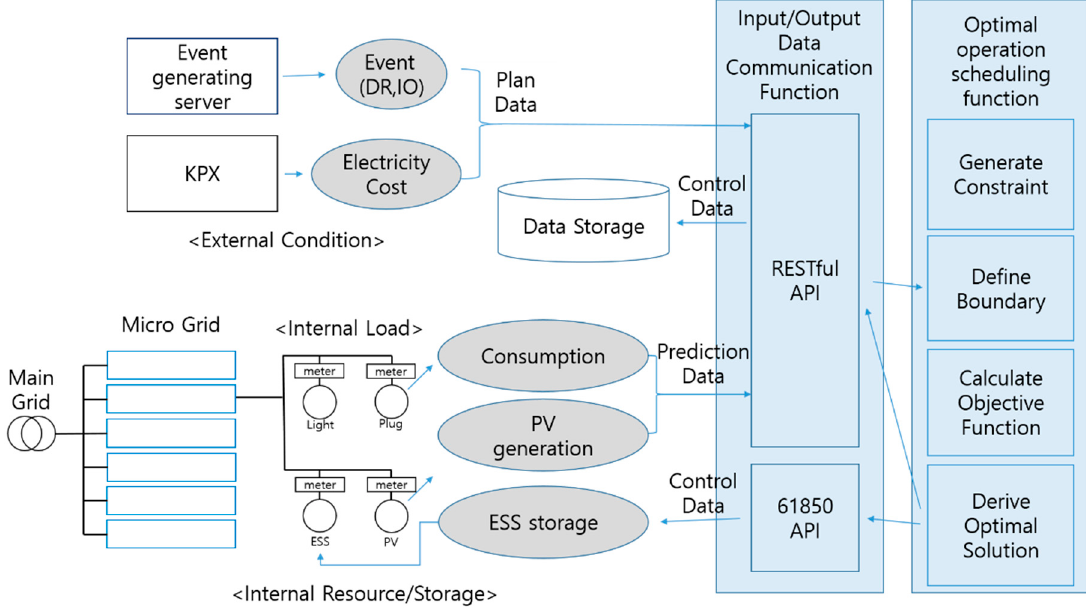
Figure 1. The operation flow diagram of a microgrid energy management system (KPS: Kepco Plant Service; DR: Demand Response; ESS: Energy Storage System).